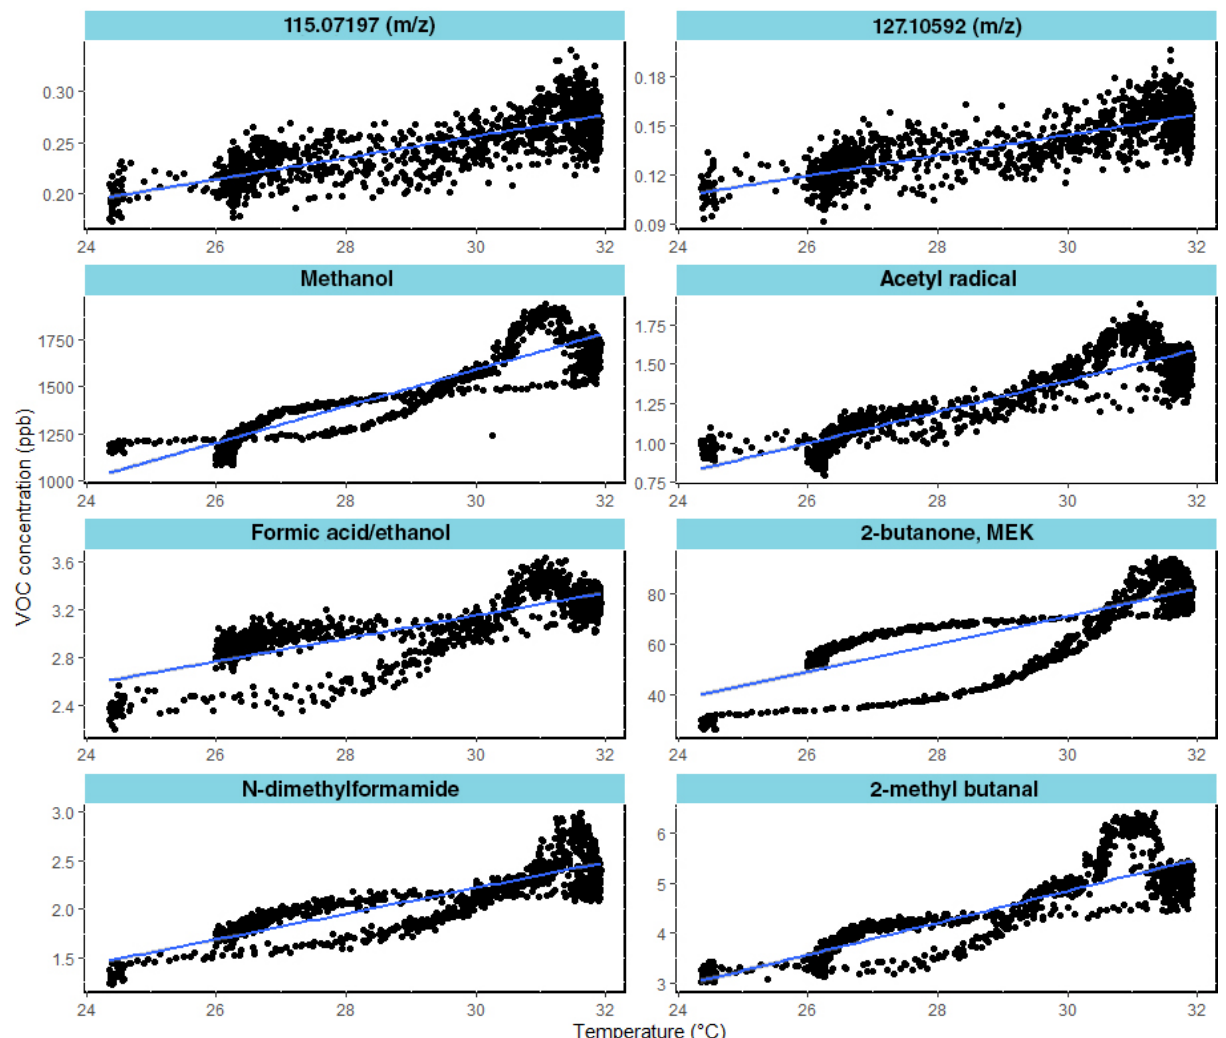
Figure 7. Correlation between VOC mixing ratios and temperature under the UV_O 3 condition. The eight most correlated VOC are shown (Pearson correlation coefficients > 0 .